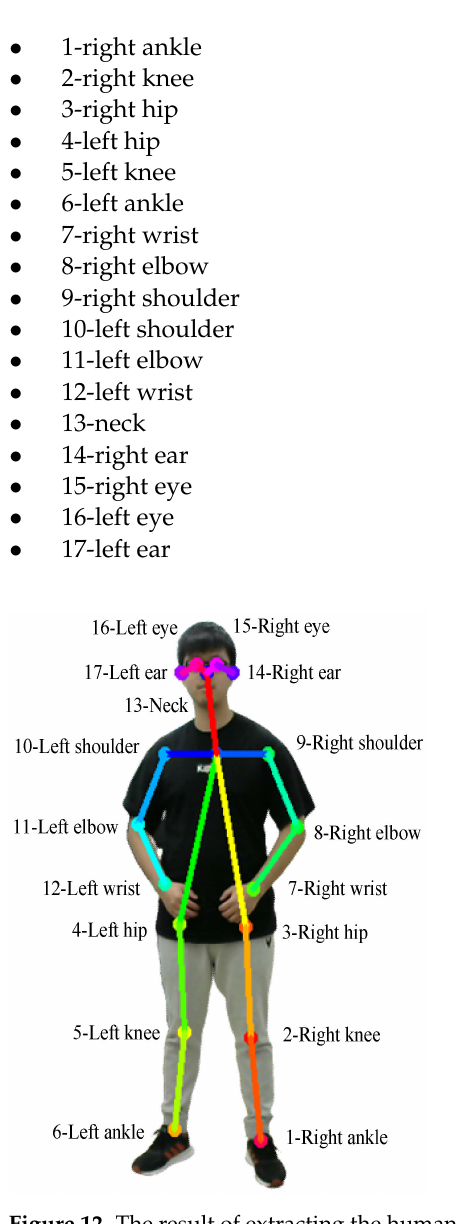
Figure 12. The result of extracting the human skeletal